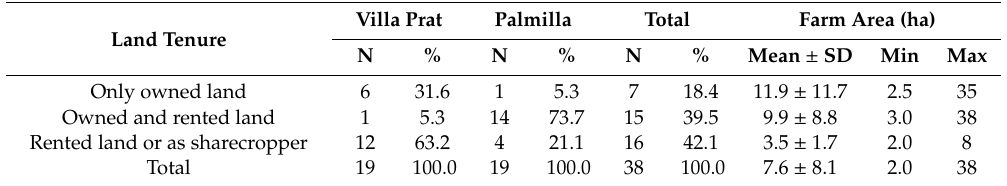
Table 1. Number of producers of chili pepper with cultivars cacho de cabra and chileno negro , grouped by